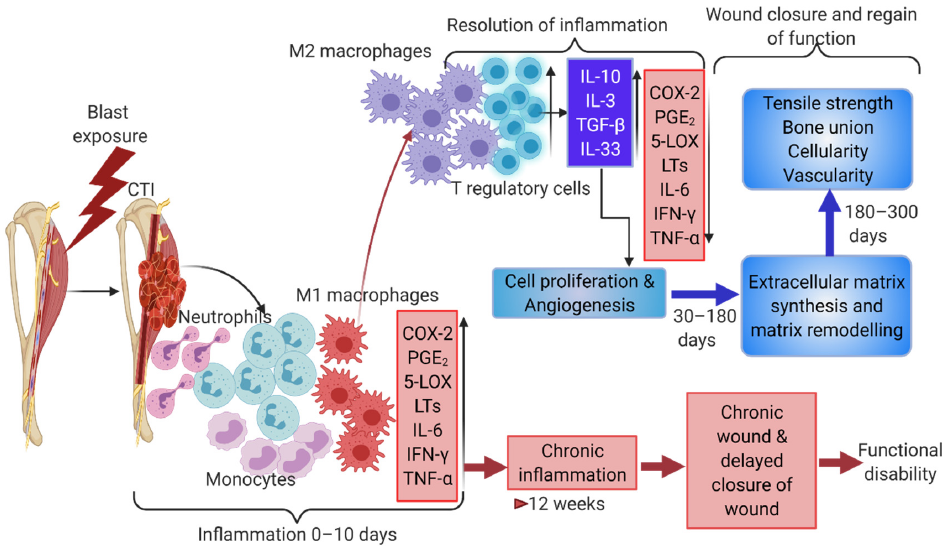
Figure 1. Composite tissue injuries involves multiple immune cells and endogenous immune pathways. Tissue-resident macrophages release chemoattractants triggering neutrophil infiltration and the simultaneous activation of complement pathway molecules in vessels. These events result in increased pro-inflammatory conditions with an increased number of M1-like macrophages. Pro-inflammatory arachidonic acid pathway metabolites, PGE2 and leukotrienes along with pro- inflammatory cytokines result in initiating precursor cells in various damaged tissues. An increase in Th2 immune response is established with an increase in IL10, IL4, and IL3, etc., which propagates M2 macrophages and Tregs that help in inducing cell differentiation and wound healing. A sustained pro-inflammatory reaction for a longer duration than needed results in a chronic wound or delayed wound closure.